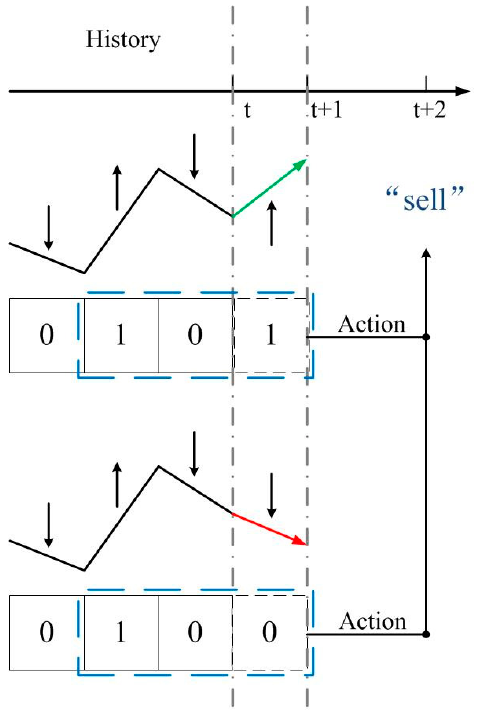
Figure 2. Representation of how the trading strategy in Table 1 decouples at time t + 2, conditioned on the price history 𝜇⃗ = (010) at time t . Table 1. Example of a strategy used in the Minority Game (Challet and Zhang 1997) and the $-Game (Andersen and Sornette 2003). Considering only up (1) and down (0) market price movements, a strategy issues a prediction for each given price history, here illustrated with price histories over the last m = 3 days. A prediction of 1 refers to the recommendation of the strategy to buy, whereas a prediction of − 1 is a recommendation to sell. Price History